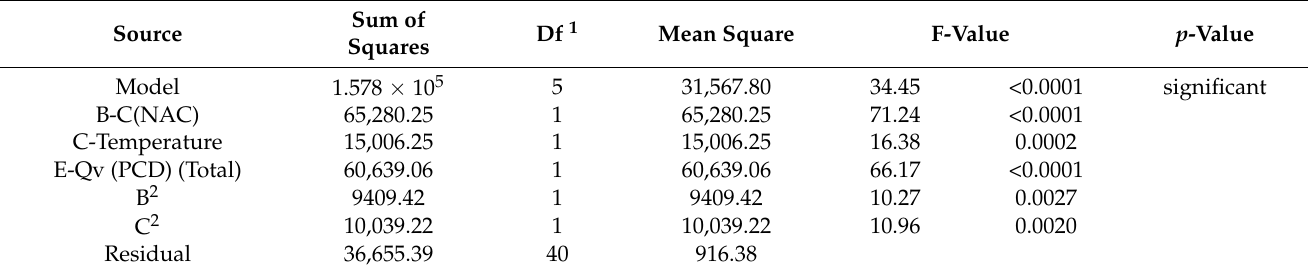
Figure 3. ( A ) Response surface plots indicating the effects of C (borate) and the reaction temperature on the peak height; ( B ) desirability 3D plot for defining the optimal conditions in the Colistin response; ( C ) normal plot of residuals; ( D ) predicted vs. actual values for the Colistin peak height. Table 1. Analysis of variance (ANOVA) for Box–Behnken design.